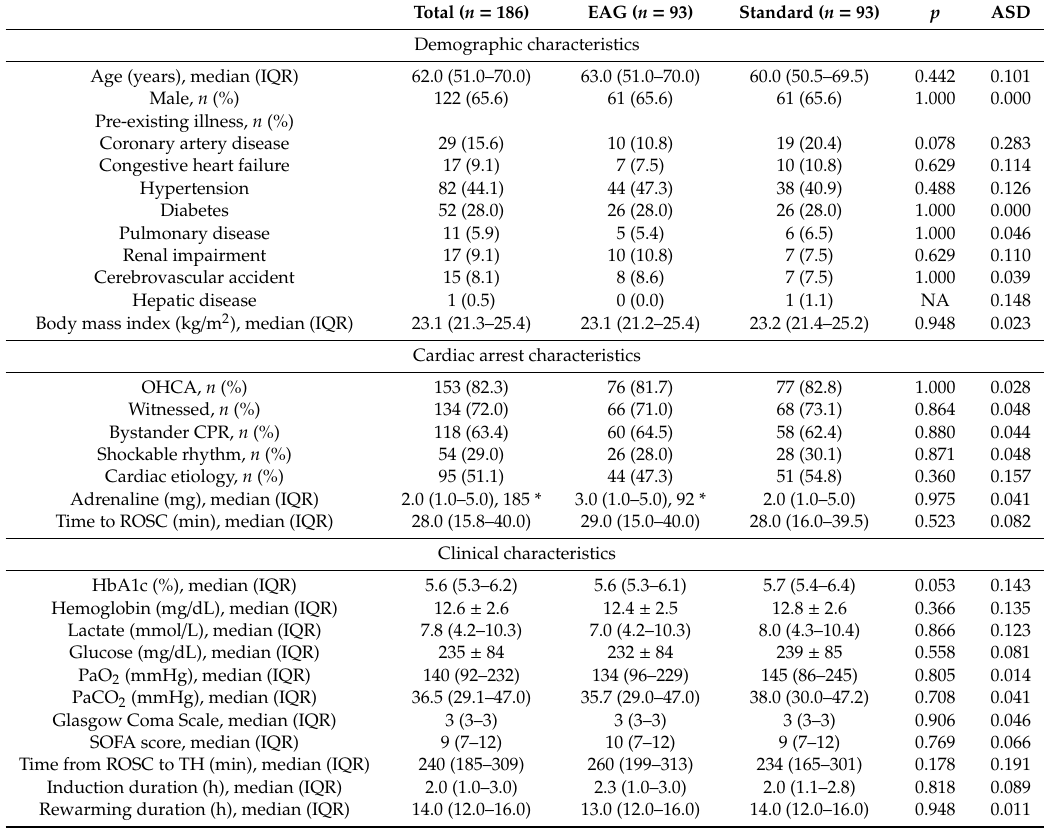
Table 3. Demographic, cardiac arrest, and clinical characteristics between EAG and standard glucose groups in the propensity score-matched cohort.